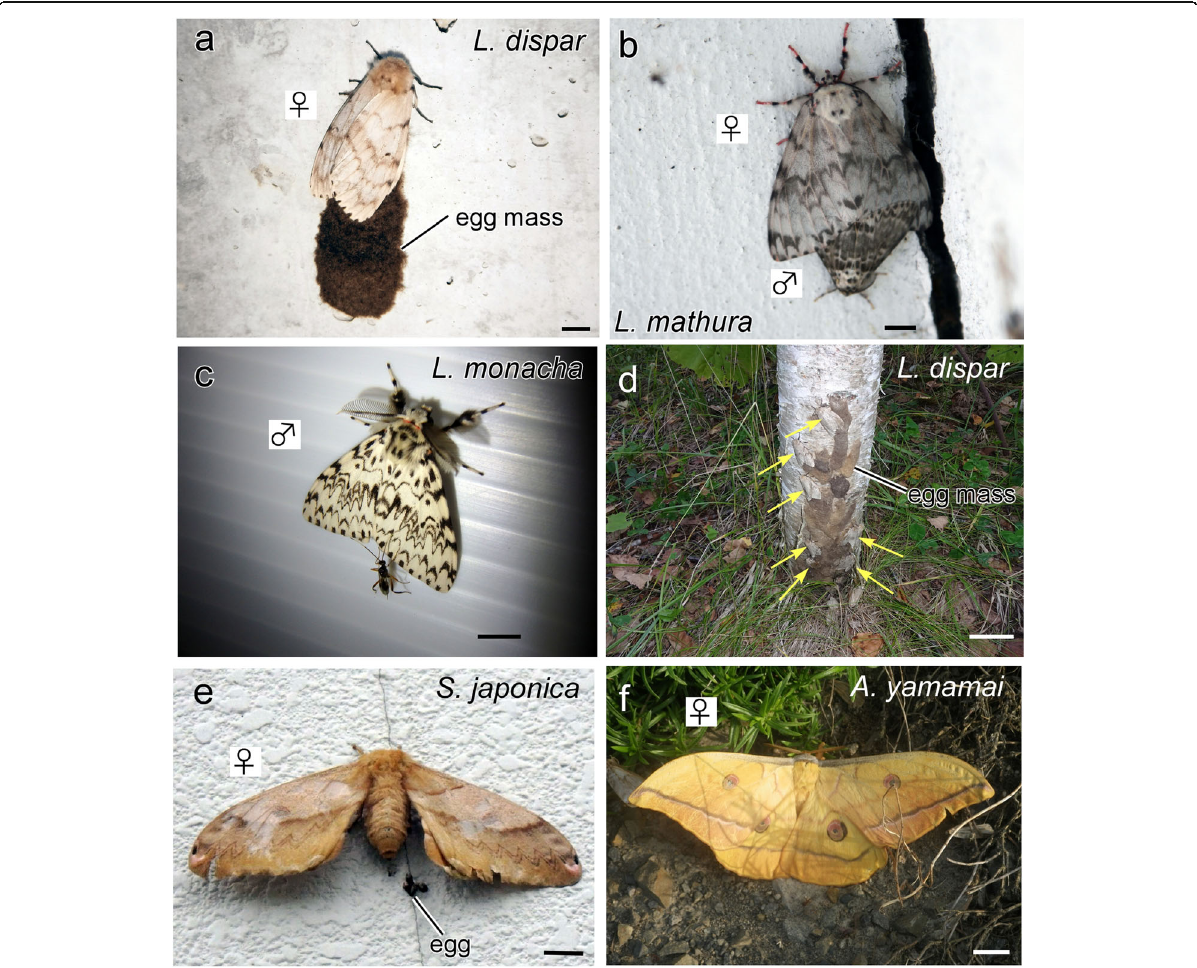
Fig. 4 Target moth species to be controlled on expressways include three species of gypsy moths ( Lymantria ), Lymantria dispar ( a ), the pink gypsy moth Lymantria Mathura, ( b ) and the nun moth Lymantria monacha ( c ); and two species of Japanese oak silkmoths (Saturniidae), Saturnia japonica ( e ) and Antheraea yamamai ( f ). A parasitoid wasp is approaching from the rear of an L. monacha moth ( c ). Gypsy moths usually lay egg masses on trunks of white birches (moths indicated by yellow arrows, d ); thus, artificial objects with a white background are favored as egg- laying sites ( a ). Photographs in ( b ) and ( f ) are courtesy of Dr. H.J. Pflüger. Scale bar = 1